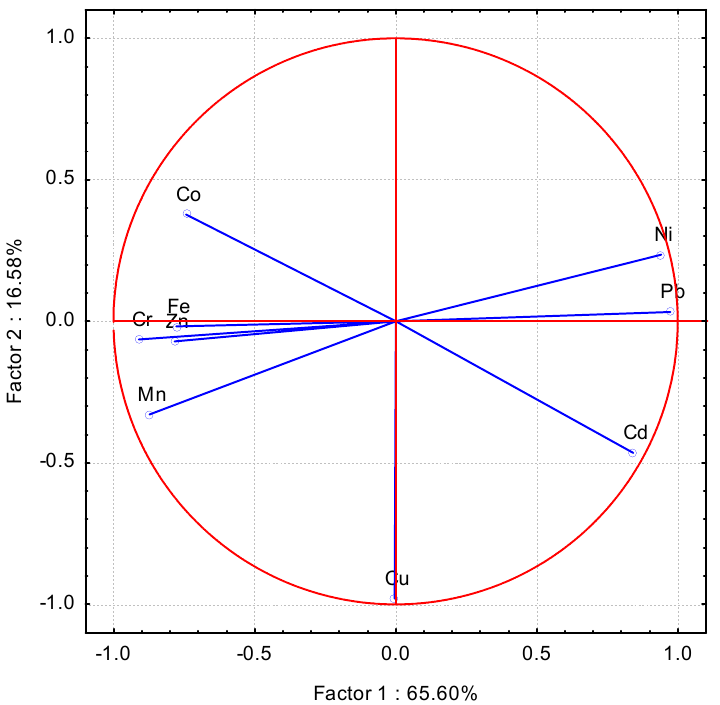
Figure 1. Content of trace elements in soil illustrated with the PCA method. Key: vectors represent analyzed variable (content of Cd, Pb, Cr, Co, Ni, Zn, Cu, Mn, and Fe).